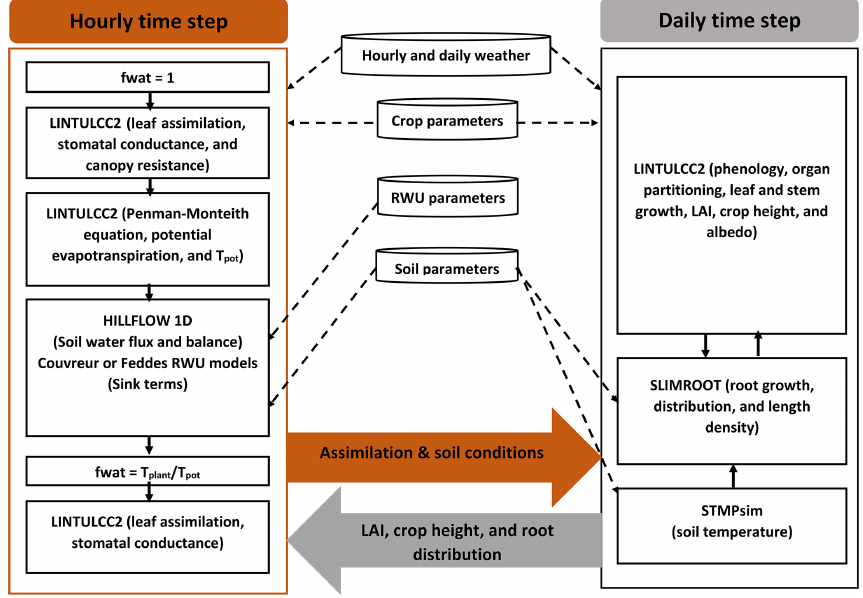
Figure 2. Description of the coupled root–shoot models in the study. The orange arrow indicates feedbacks from the hourly simulations to daily simulation, while the grey arrow indicates feedbacks from the daily simulations to the hourly simulations. The dashed black arrows denote the weather input and parameters to the subroutines. The continuous black arrows indicate the links amongst the modeling